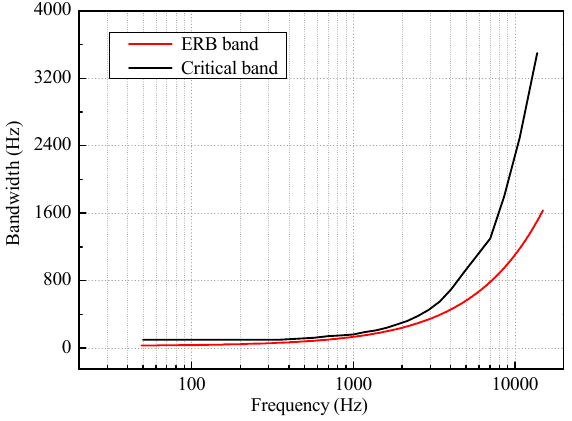
Figure 2. Bandwidths of ERB and critical bands.